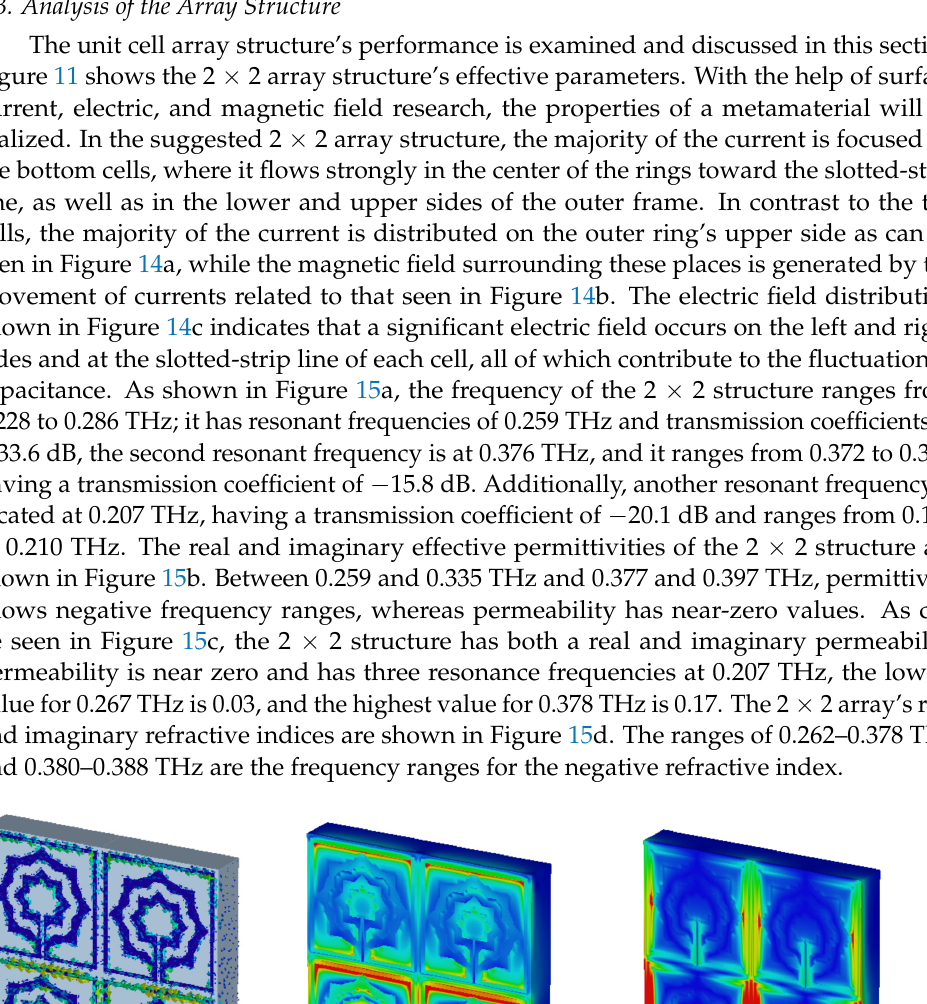
( d ) Figure 15. Effective parameters of the 2 × 2 array structure: ( a ) scattering parameters; ( b ) permittiv- ity; ( c ) permeability; ( d ) refractive index. Figure 16 demonstrates the effective parameters of the 4 × 4 array structure. Figure 16a indicates that it has a frequency range of 0.257–0.379 and 0.376–0.381 THz with reso- nant frequencies of 0.257 and 0.379 THz and transmission coefficients of − 35.2 and − 13.5 dB, respectively. Figure 16b depicts the real and imaginary effective permittivity of the 4 × 4 structure. Permittivity plots exhibit a negative frequency range between 0.257 and 0.332, 0.347 and 0.355, and 0.380 and 0.397 THz, whereas permeability plots are near zero in the relevant band. However, Figure 16c depicts the real and imaginary permeability of the 4 × 4 structure. The real permeability is close to zero and has resonant frequencies at